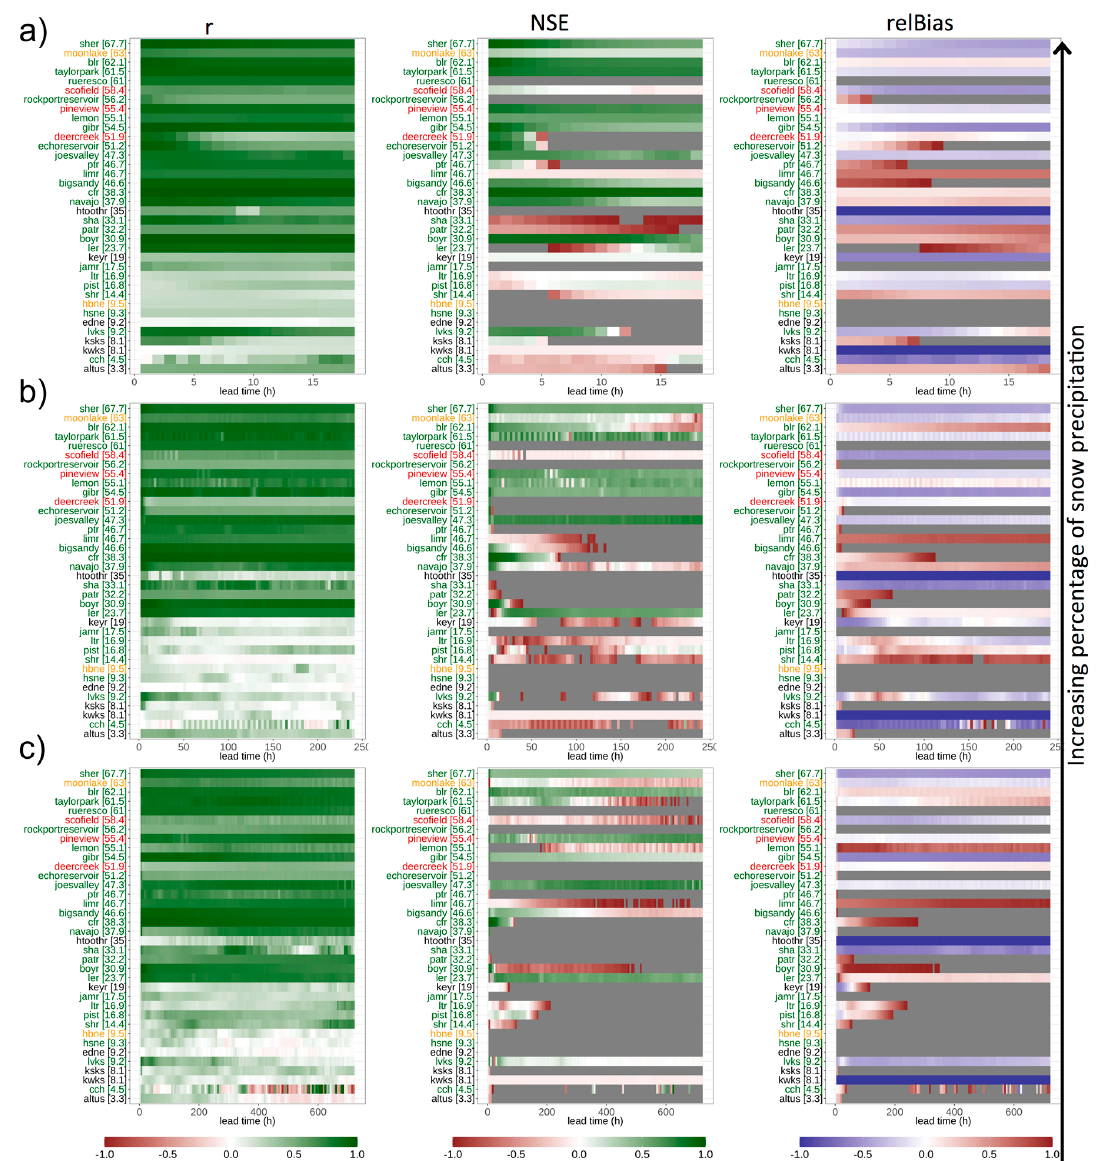
Figure 5. Performance of NWM reservoir inflows across lead times for one year, where reservoirs in each subplot are ordered from bottom to top by the percent contribution of snow in total precipitation (percentages are listed in parenthesis on the y -axis with reservoir name). Each column from left to right columns illustrate r , NSE, relBias , where the metric is scaled by color density and grey is out of valid range ( relBias > +1 or relBias < − 1 and NSE < − 1). For r and NSE , green values are higher performance and red is worse; and for relBias , blue is high-biased and red is low-biased. The subplot rows are forecast cycles: short ( a ), medium ( b ), long ( c ).